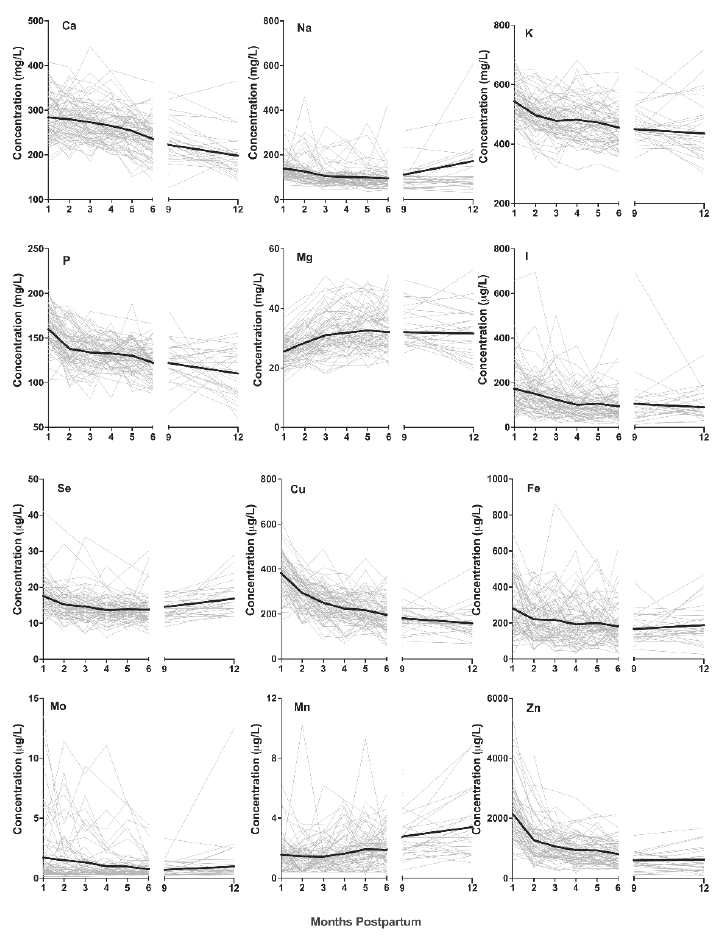
Figure 1. Macro- and trace elements in human milk over the first 12 months Figure 1. Macro ‐ and trace elements in human milk over the first 12 months postpartum. The grey lines indicate individual plots; the black lines indicate mean values. Abbre ‐